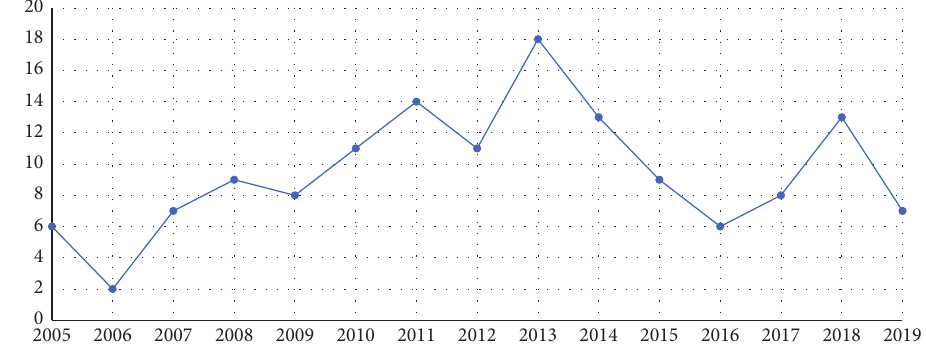
Figure 12: Statistics of the included papers by publication